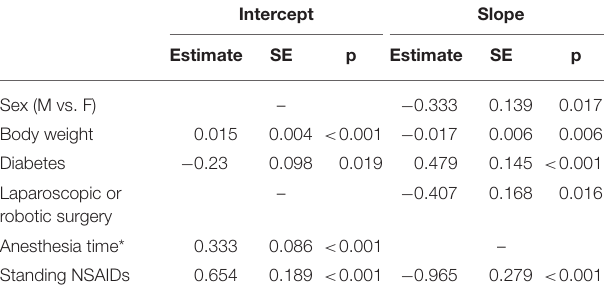
TABLE 3 | Final multiple predictors model for postoperative pain trajectory.